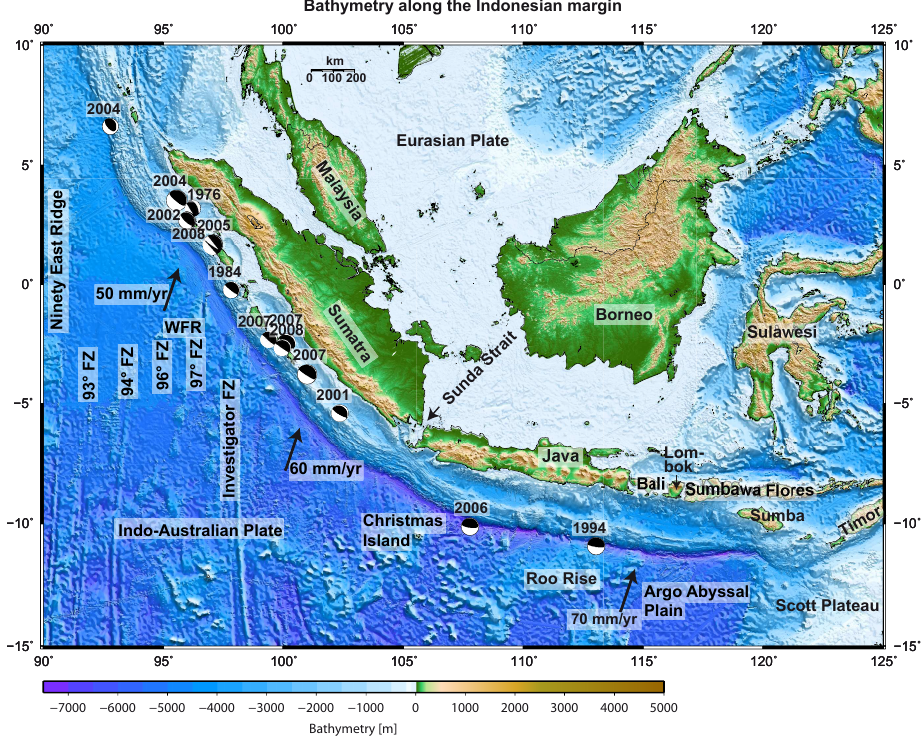
Fig. 1. Bathymetry of the Indonesian margin underlain by satellite altimetry (Smith and Sandwell, 1997). See text for details on data information. Major tectonic features on the incoming plate are annotated, off Sumatra mainly N-S trending fracture zones, off Java elevated plateaus and seamounts. Plate motion direction and velocity (indicated by annotated black arrows; after Simons et al., 2007) vary along the entire margin relative to the upper plate. Centroid Moment Tensors (CMT) of recent (starting from 1976) M w ≥ 7 subduction fault related earthquakes are shown across the Sunda arc (size of “beach balls” correlates with earthquake magnitude, from http://www.globalcmt.org). Further details are discussed in text. WFR – Wharton fossil